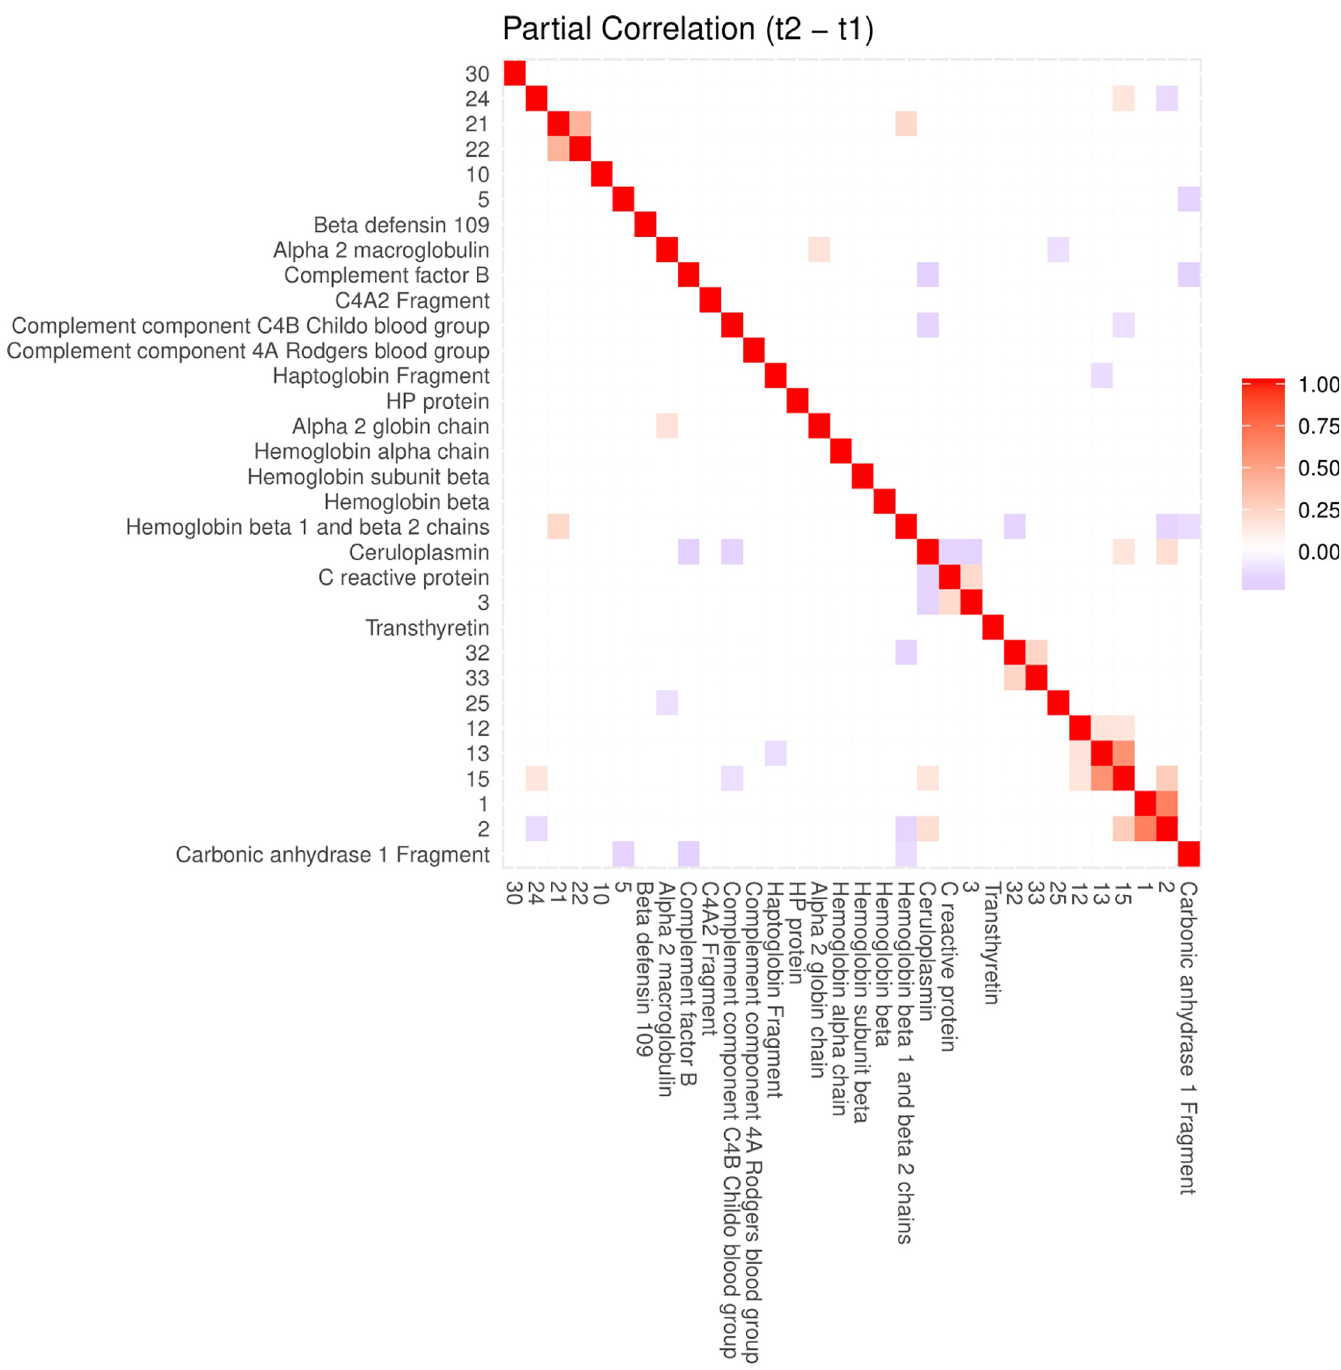
Fig 5. A heatmap of partial correlations between differences in spot intensities from t 1 to t 2 . Contrary to the heatmap in Fig 3, a heatmap of partial correlations as depicted here is relatively uncluttered. Sparsity was achieved by estimating the support of the inverse covariance matrix through a local false discovery rate of 0.05 as described in the methods section. Row and column order were set by hierarchical clustering using f ( x ) = 1 − pcor ( x ) as distance function. Heatmaps of partial correlations corresponding to the other time point transitions are included as supplementary figures (S23, S24 and S25 Figs).